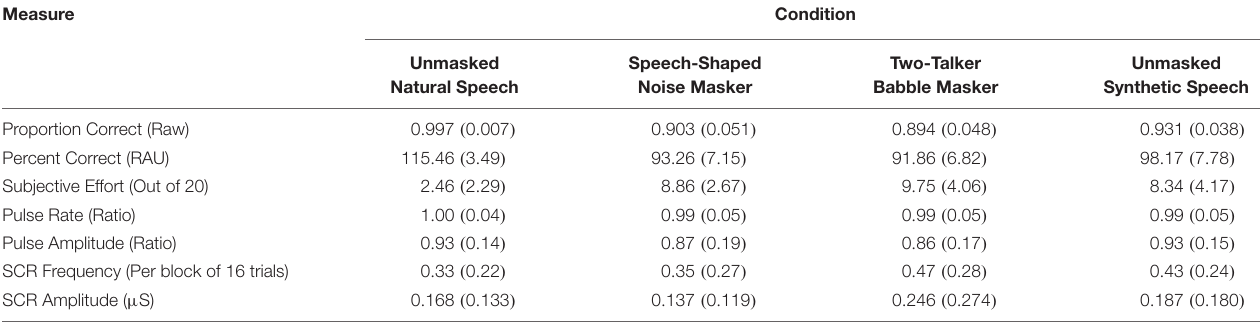
Standard deviations shown in parentheses for all measures. TABLE 3 | Mean scores on the NASA TLX subscales in each condition.